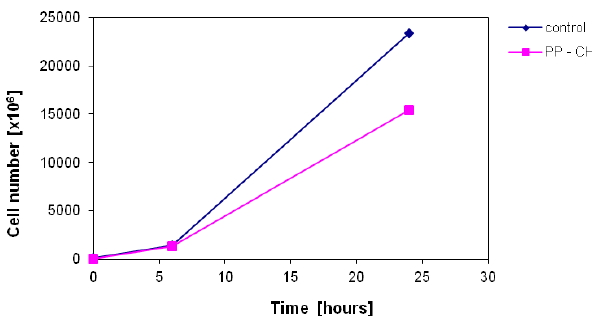
Figure 11: Time dependance of Staphylococcus aureus cell number growing in the presence of PPNW coated with chitosan (PP-CH) in comparison with samples without PPNW